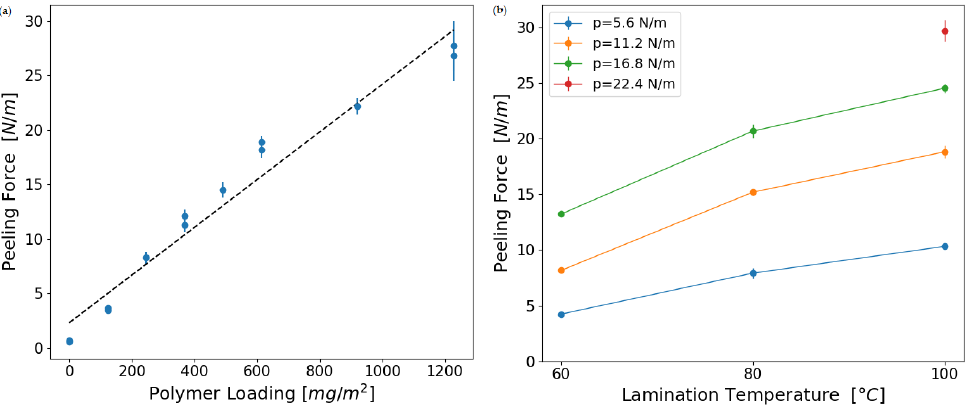
Figure 3. Interface stability of laminated ESLs consisting of PE separators with Polymer B and graphite anode. ( a ) Peeling strength depending on the amount of polymer applied to the separator when laminated at 100 °C and 22 N/m. ( b ) Peeling strength depending on lamination temperature and line force using a polymer loading of approx. 614 mg/m 2 .